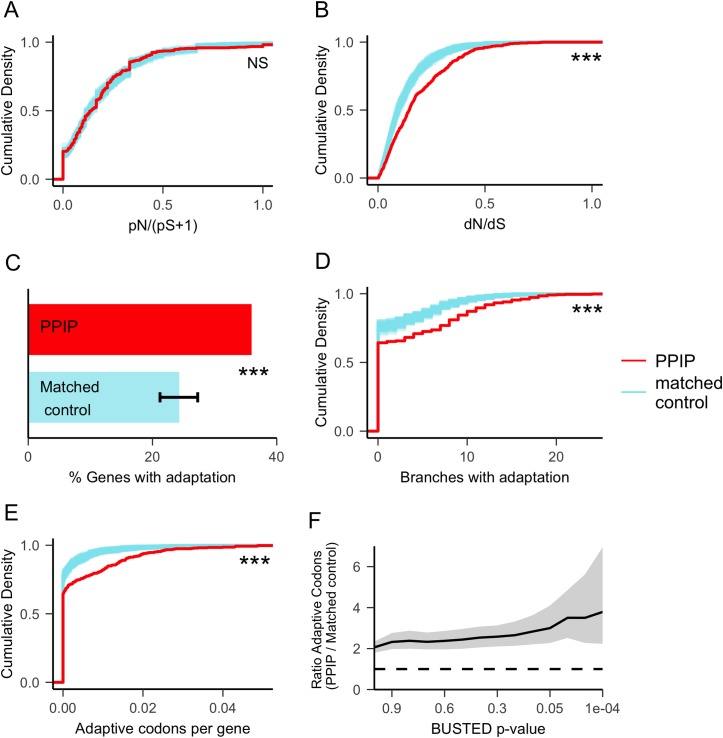
PPIPs have experienced a significant excess of adaptive substitutions in mammals.All comparisons are made between PPIPs and carefully matched control proteins (Methods, Permutation Tests). (a) Evolutionary constraint across great apes, as measured by the ratio of non-synonymous to synonymous polymorphisms, is equivalent in PPIPs and matched controls. The thick red line represents the cumulative density of pN/(pS+1) for PPIPs, whereas the cloud of thin blue lines represents the cumulative densities of 100 sets of matched controls. (b) Across 24 mammal species, the ratio of non-synonymous to synonymous substitutions is elevated in PPIPs versus matched controls. Lines as in (a). (c) BUSTED detects mammalian adaptation in 37% of PPIPs and, on average, 24% of matched controls. Error bars indicate the 95% range of the proportion of matched control genes with evidence of BUSTED adaptation, over 100 sets of matched controls. (d) Across the mammalian phylogeny (Fig 1), BS-REL tests identify PPIPs as evolving adaptively on a higher number of branches. Lines as in (a). (e) BS-REL tests identify a higher proportion of codons in PPIPs as evolving adaptively. Adaptive codons per gene are given as an average across all branches. Lines as in (a). (f) The ratio of adaptive codons in PPIPs versus matched controls increases (p = 7x10-5) as the BUSTED threshold for including BS-REL estimates becomes more stringent. The solid line indicates the mean excess; the dashed line indicates the 1:1 expectation; gray shading indicates 95% confidence intervals. In all panels, *** = p<0.001; NS = p>0.05.